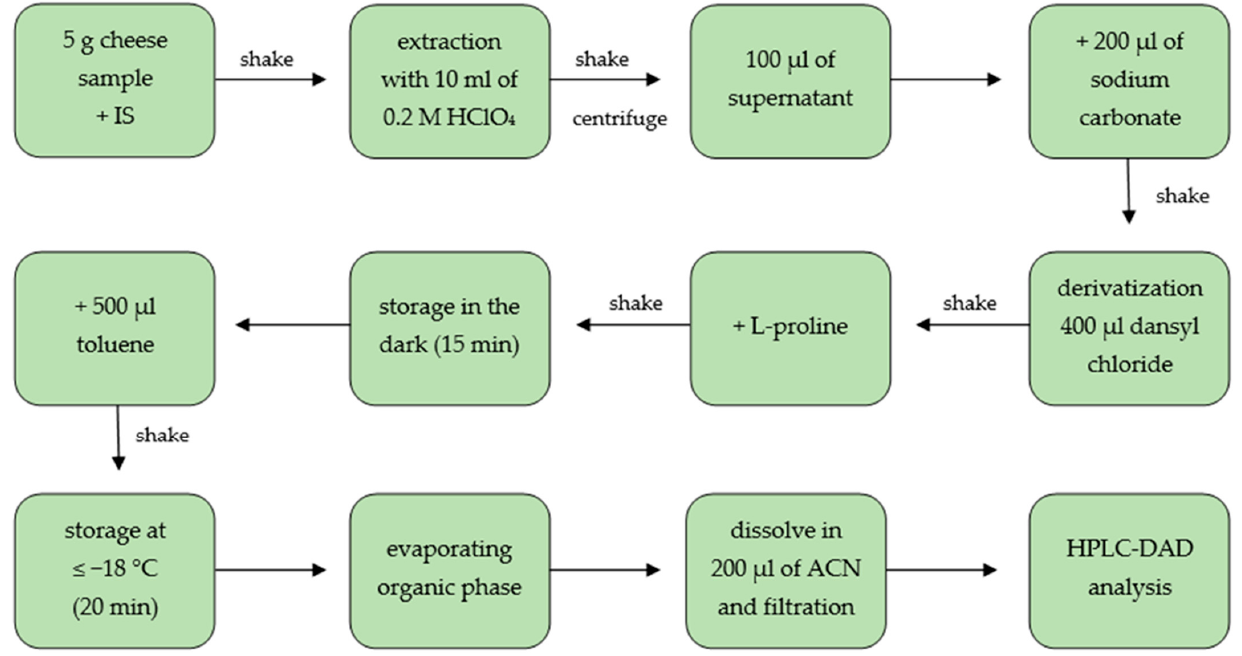
Figure 3. Scheme of sample preparation for the determination of BAs in cheese (IS: internal standard, ACN: acetonitrile, HPLC-DAD: high performance liquid chromatography with diode array detector).